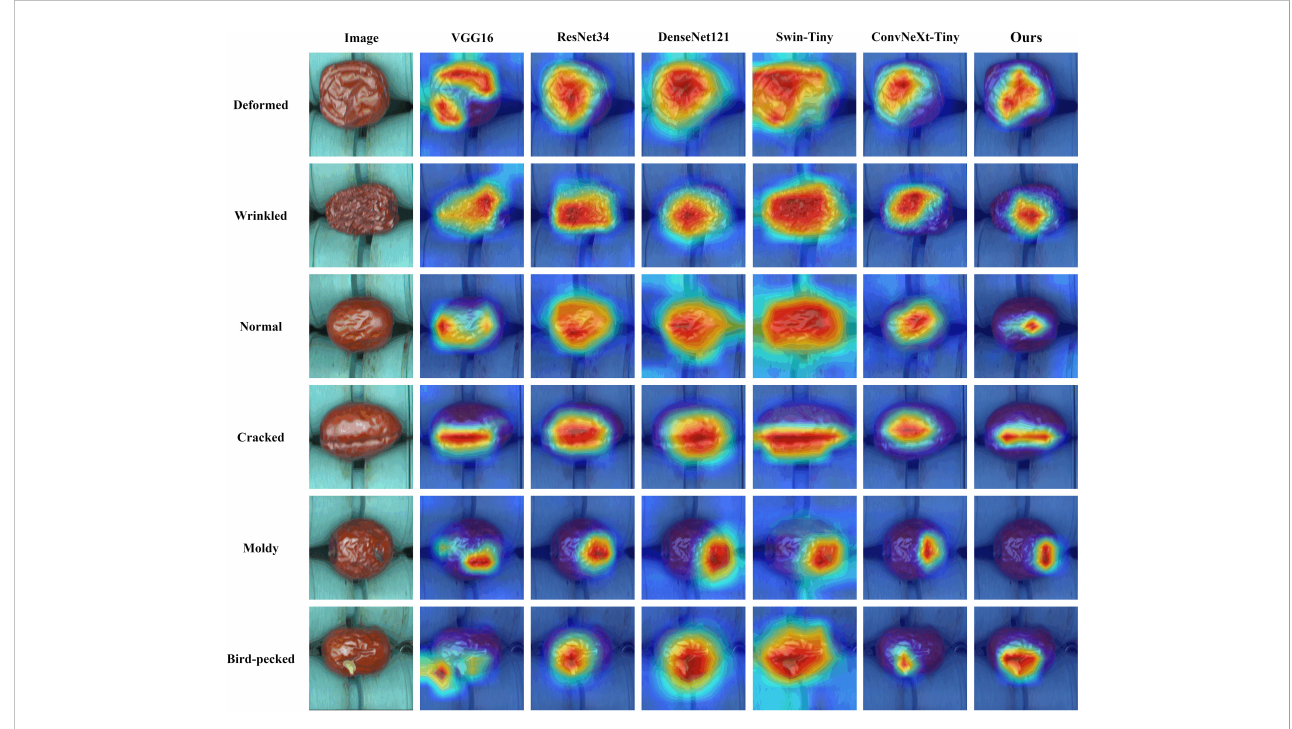
FIGURE 11 Comparison of heat maps generated by Grad-CAM for each